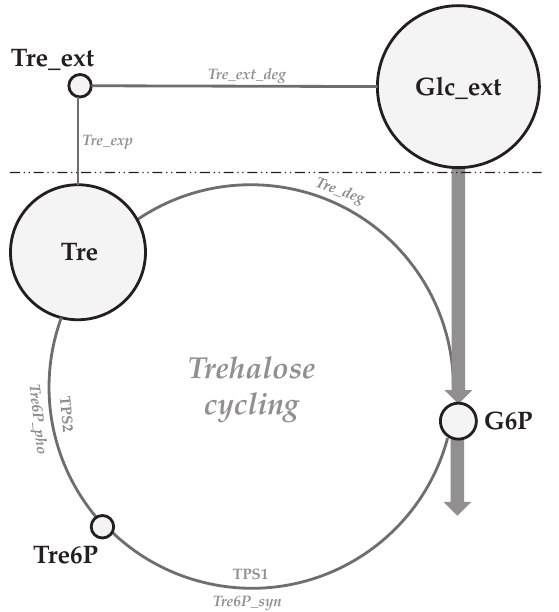
Figure 1. An overview of trehalose cycling in Penicillium chrysogenum . Tre6P is formed through the transfer of a glucosyl residue from uridine-diphospho-glucose (UDP-glucose) to G6P, which is catalyzed by Tre6P synthase (encoded by tps1 ). Trehalose is then produced through the dephos- phorylation of Tre6P, which is catalyzed by Tre6P phosphatase (encoded by tps2 ). Trehalose can be exported outside the cell, and it can be degraded into glucose via extracellular trehalase. Tre: trehalose; Glc_ext: extracellular glucose; Tre_ext: extracellular trehalose; G6P: glucose-6-phosphate; Tre6P: